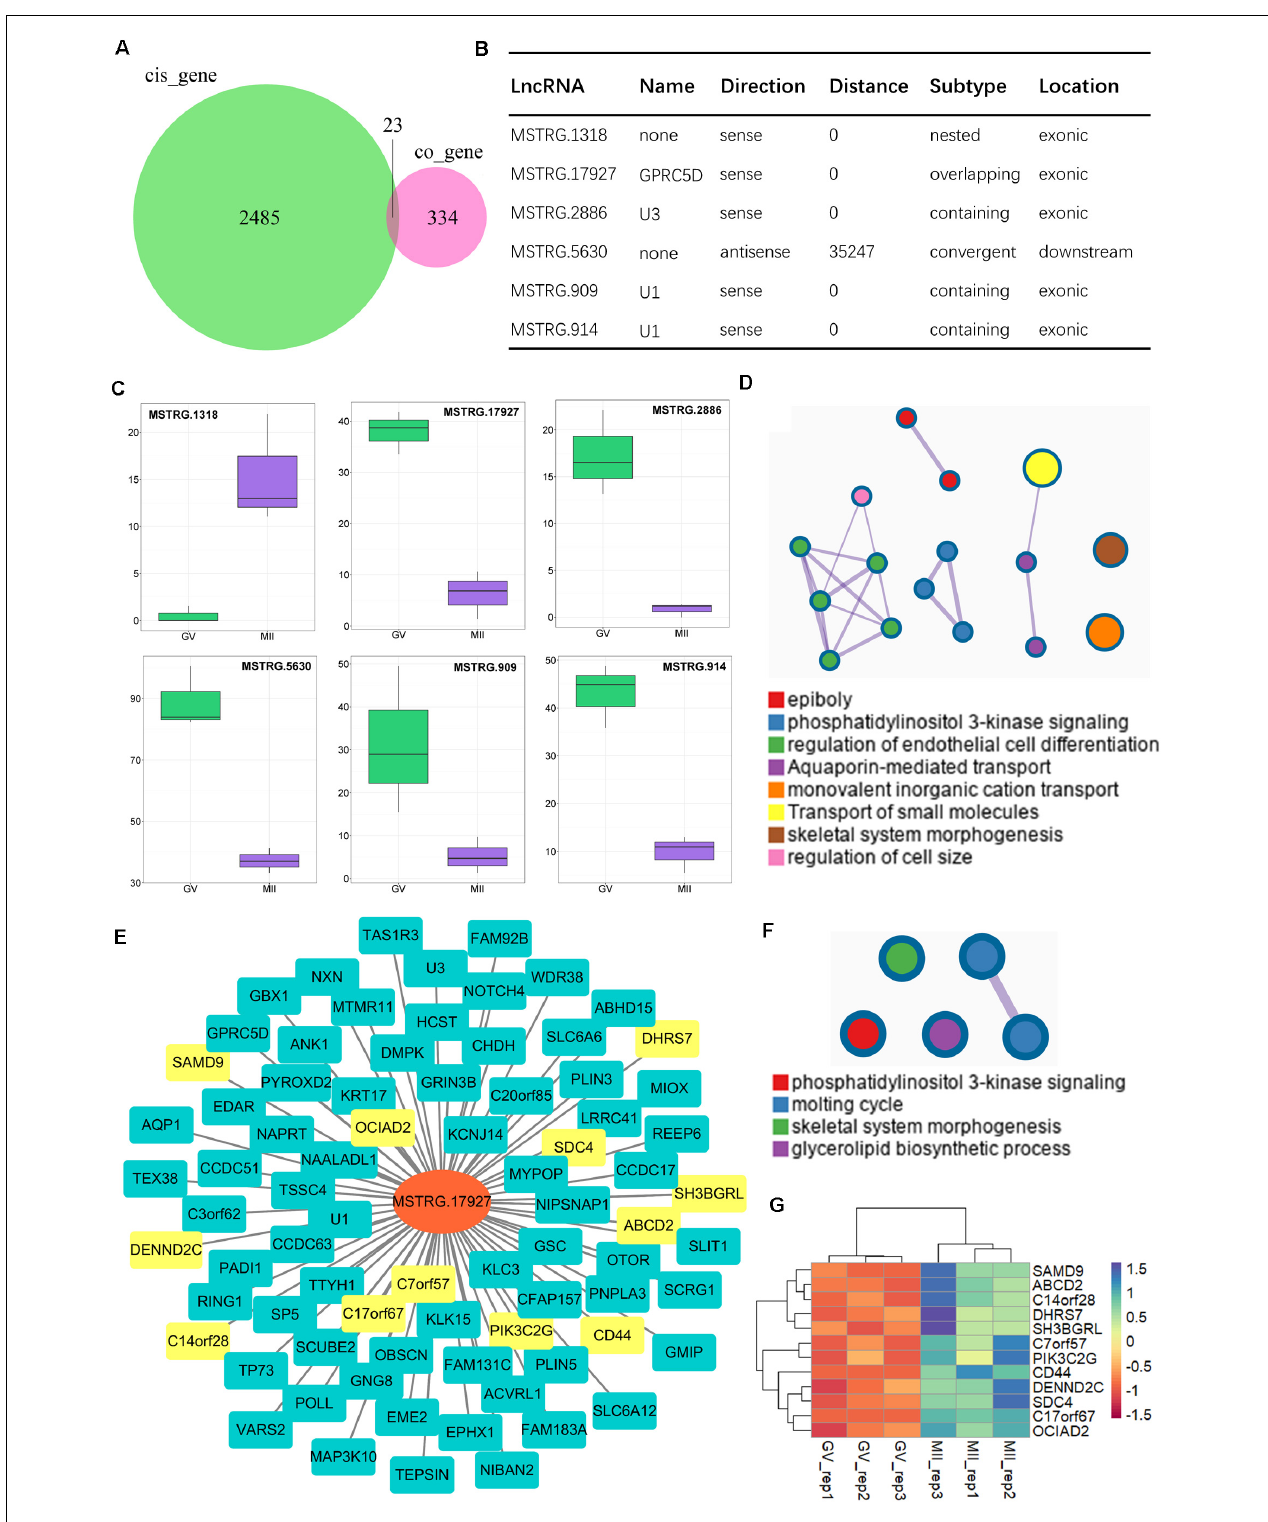
FIGURE 6 | Identification of core lncRNA–mRNA networks for the maturation of ovine oocytes. (A) Venn plot of cis -regulation with co-expressed genes; common regions refer to candidate core genes. (B) Candidate core lncRNA–mRNA network. (C) Expression of core lncRNAs from GV to MII stages. (D) Enrichment analysis of genes targeted by core lncRNAs. (E) Core lncRNA–mRNA network of targeted genes and MSTEG 17927; the yellow symbol marks negative regulatory genes, and the cyan marks positive regulatory genes. (F) Functional enrichment analysis of targeted genes of MSTEG 17927. (G) Expression of negative regulatory genes targeted by MSTEG